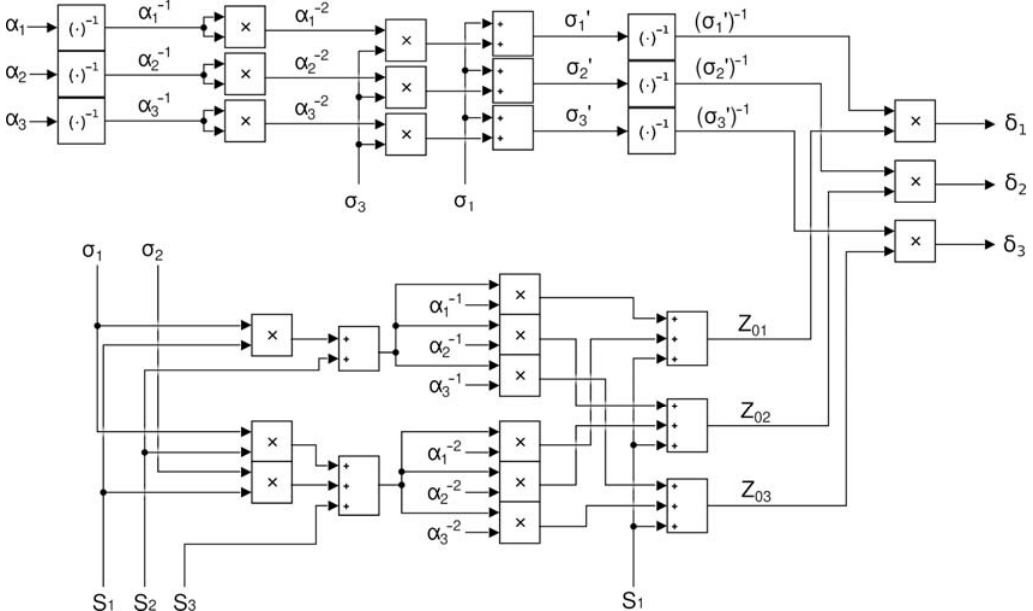
Figure 4. Error magnitude evaluation with ν = 3 implemented with the Forney algorithm. The blocks shown are additions, multiplications, and inversions ( ( · ) ) over the Galois